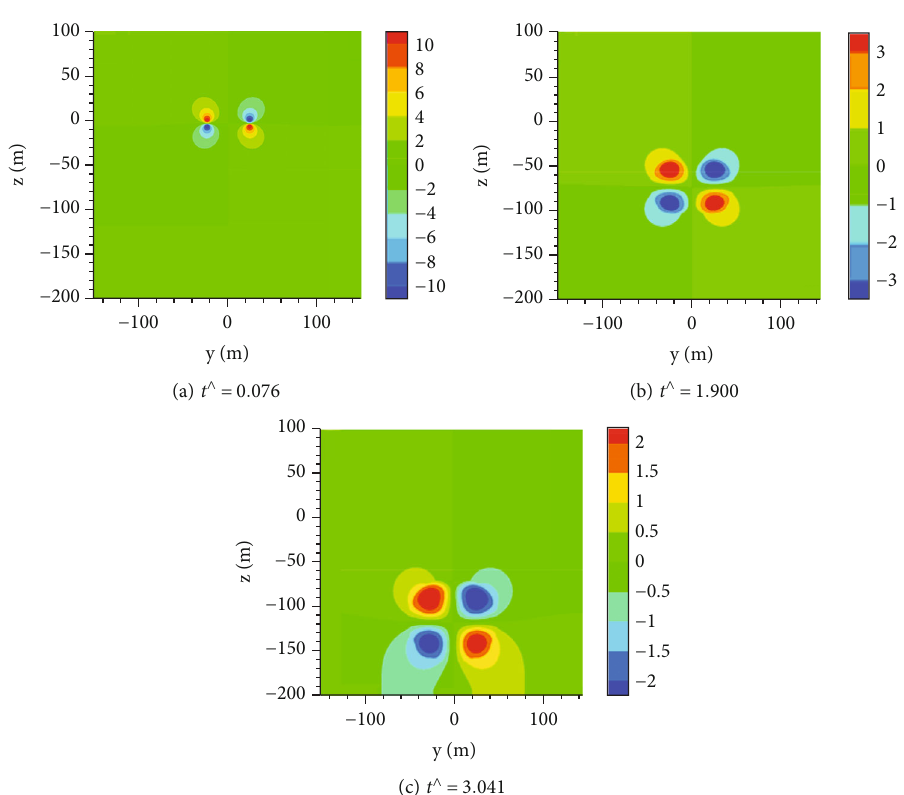
Figure 12: Contours of y velocity at di ff erent times when there is no